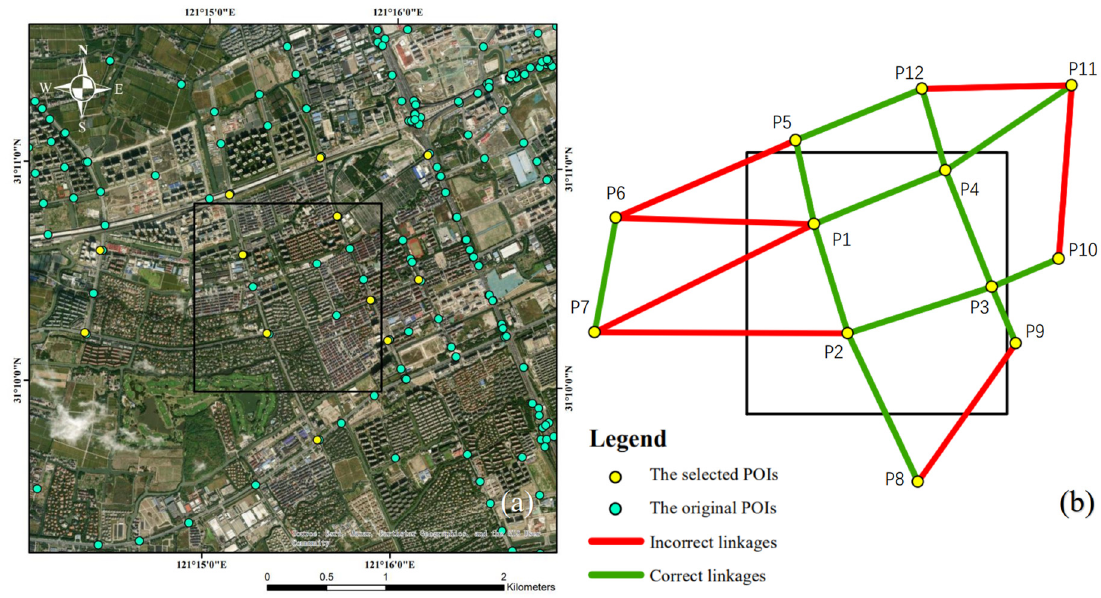
Figure 8. The original POIs overlaid on a GeoEye image in Area-I ( a ) and the selected POIs for road linkages ( b ), where the black box indicates the Area-I under study.